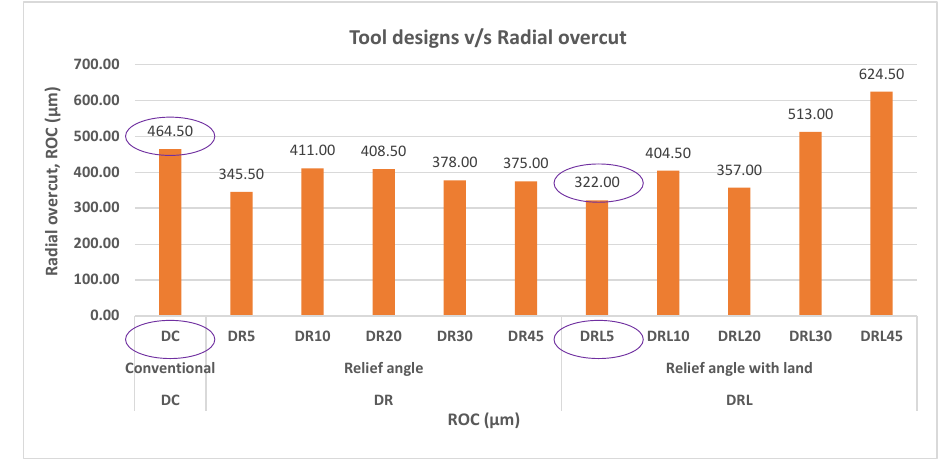
Figure 6. Effect of electrode designs on radial overcut of machined hole. Figure 6. E ff ect of electrode designs on radial overcut of machined